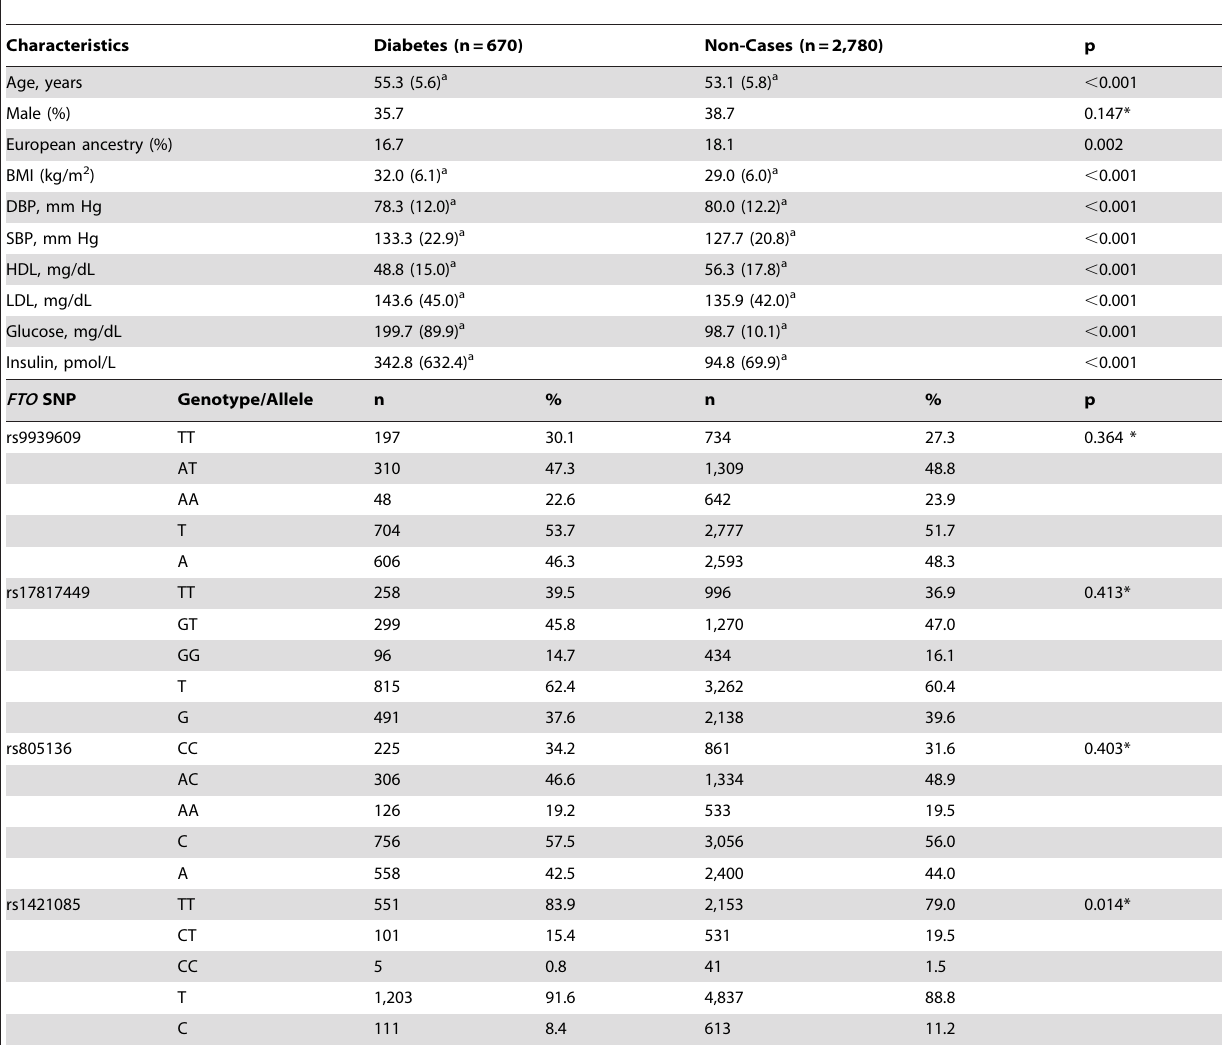
Table 1. Clinical characteristics and FTO SNP genotype frequencies in African-Americans stratified by diabetes case status.